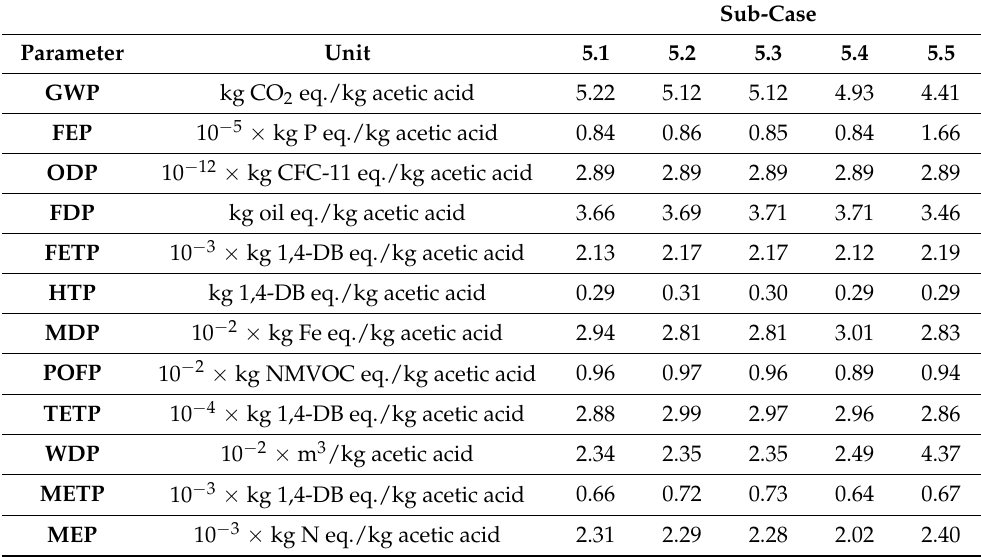
Table 10. LCA results, according to ReCiPe, for the sub-cases correspondent to case 5.